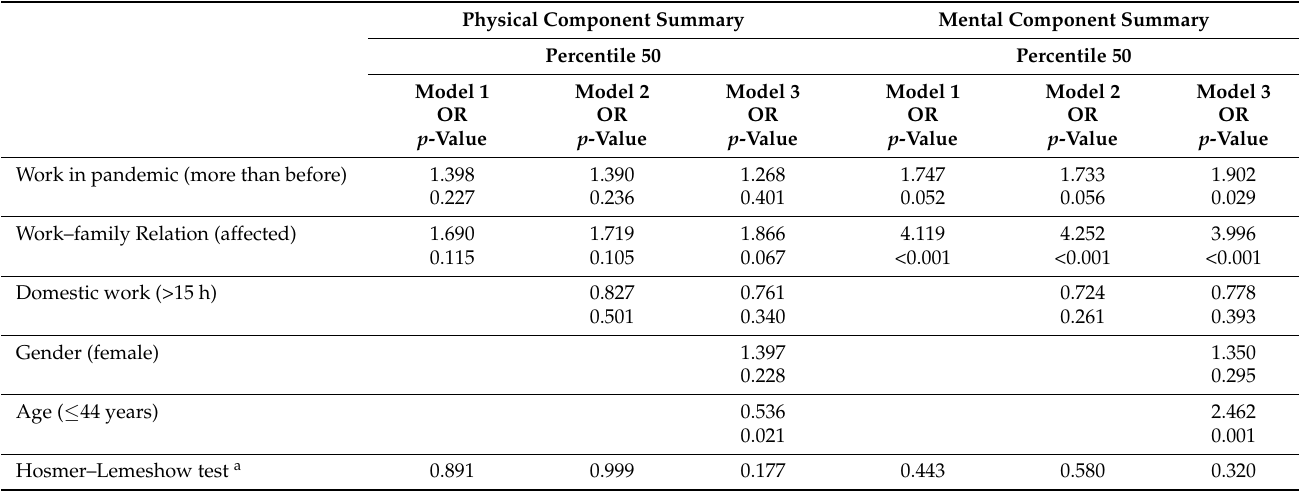
Table 4. Logistical regressions for association of the 50th percentile of the Physical Component Summary and Mental Component Summary with sociodemographic and work characteristics adjusted by gender and